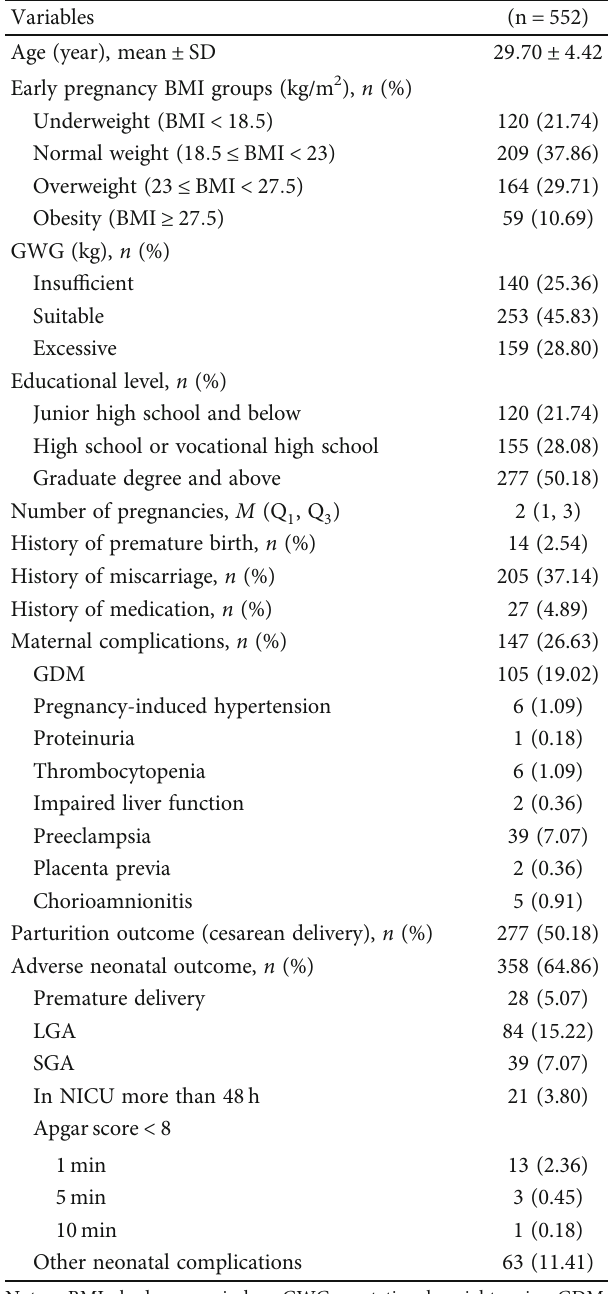
Table 1: Basic characteristics of the included